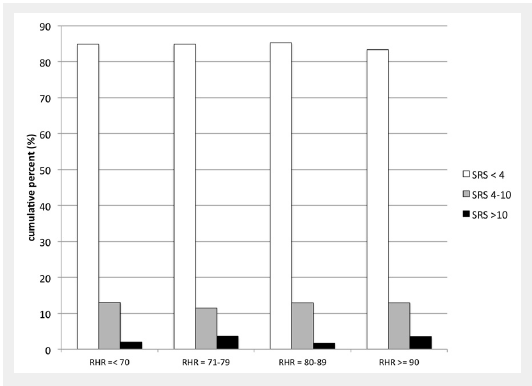
Graphics illustrating the interrelationship between the quartiles of resting heart rate (RHR in bpm) and the extent of myocardial scar (SRS) as assessed by MPS. Note that RHR was related neither to severity of myocardial ischaemia (p = 0.798), nor to the extent of myocardial scar (p =